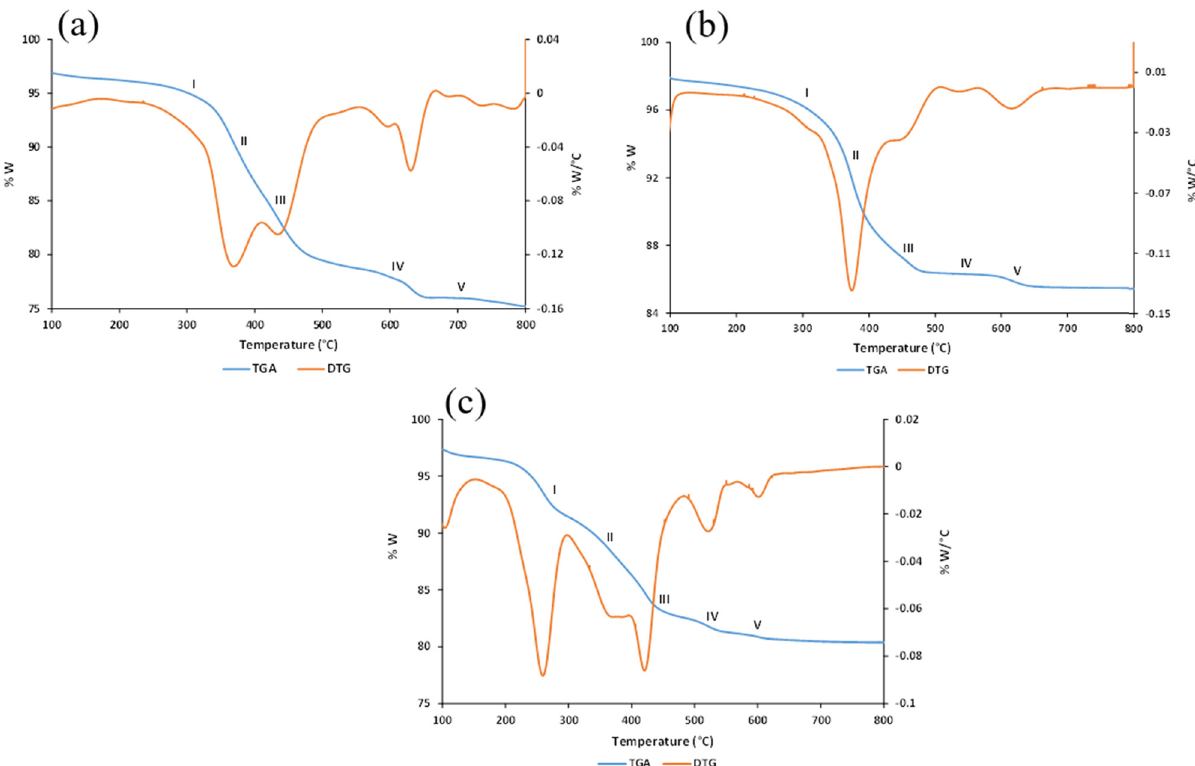
Figure 6: TGA – DTG curves of Bi/AC composites prepared with ( a ) 8 mmol, ( b ) 24 mmol, and ( c ) 32 mmol BNP.